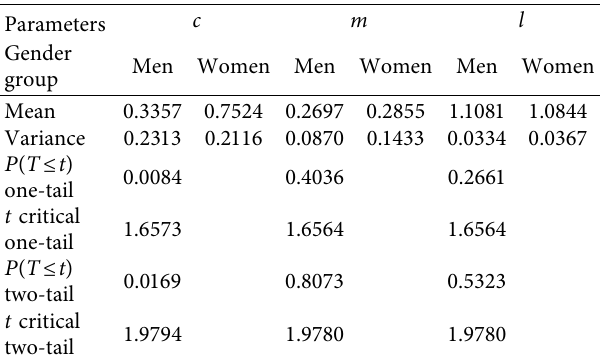
Table 5: Two-sample t -test of CF parameters between men and women groups.